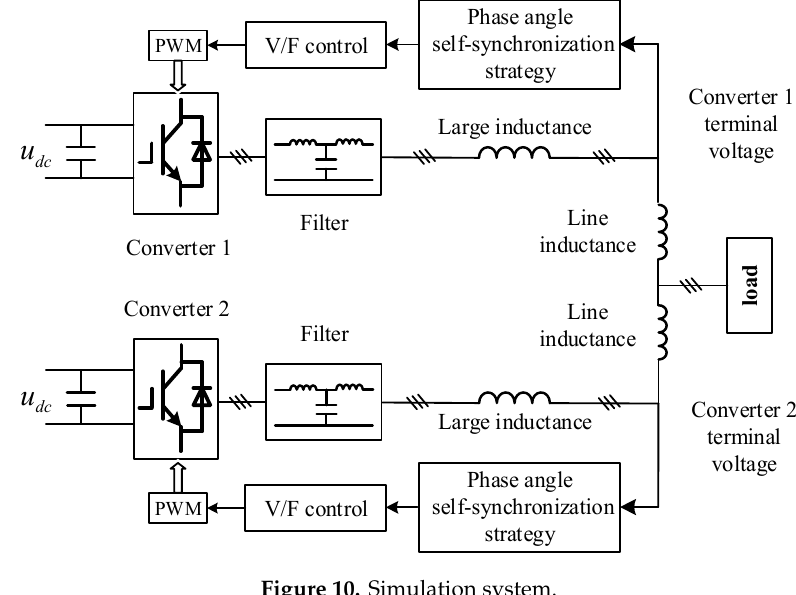
Figure 10. Simulation system.